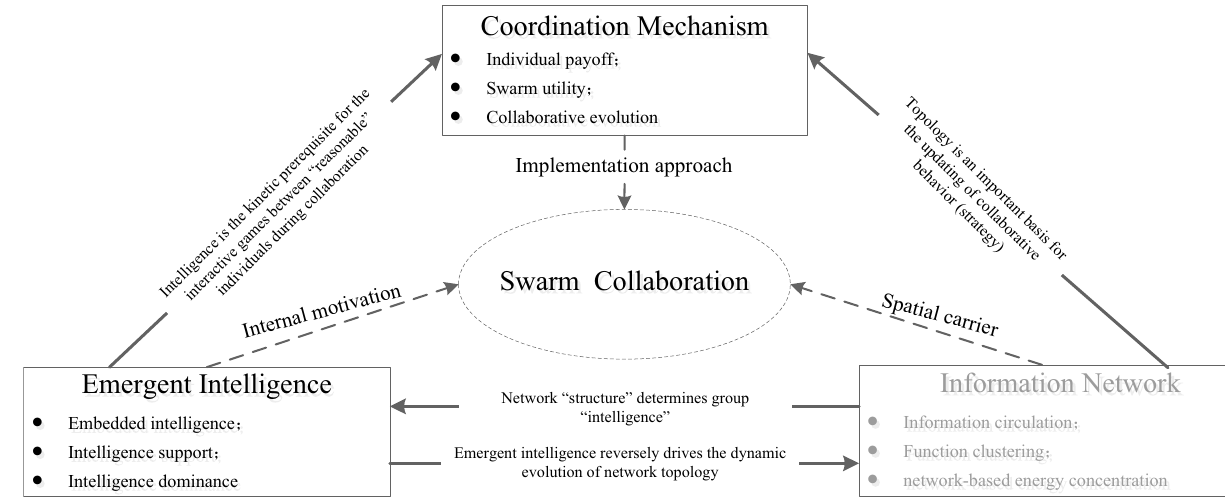
Figure 2. Framework for autonomous collaborative behaviour in unmanned